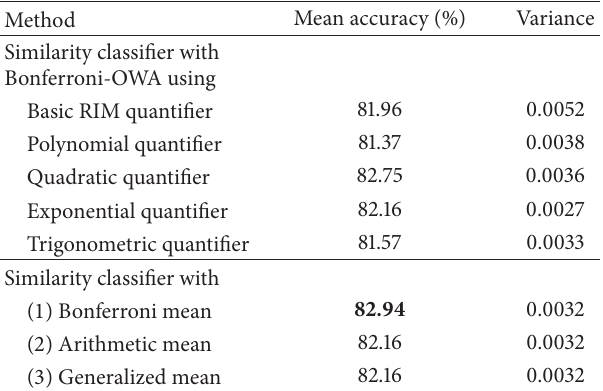
Table 8: Classification results with the lung cancer data